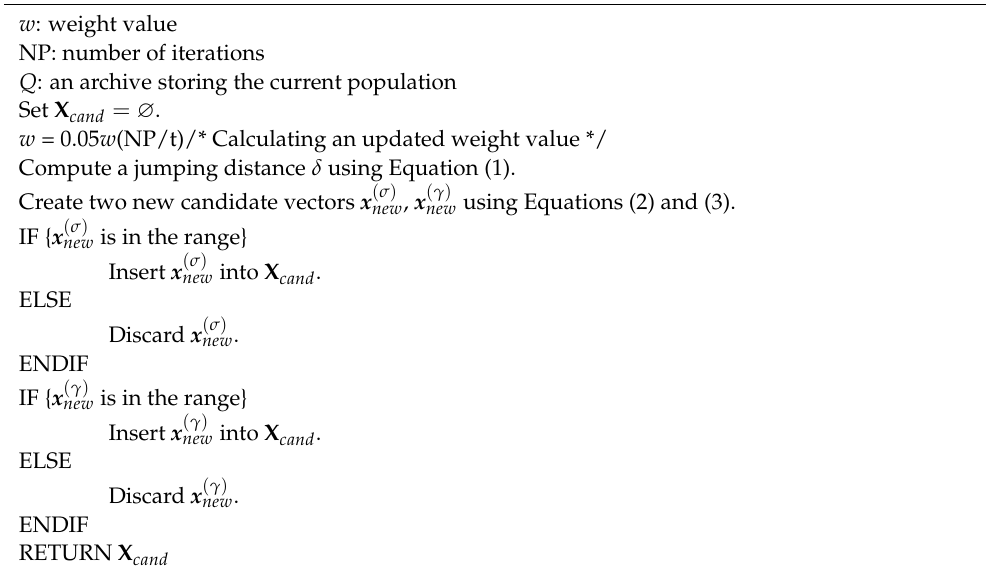
( σ ) ( γ ) new , x new within the pre-specified search